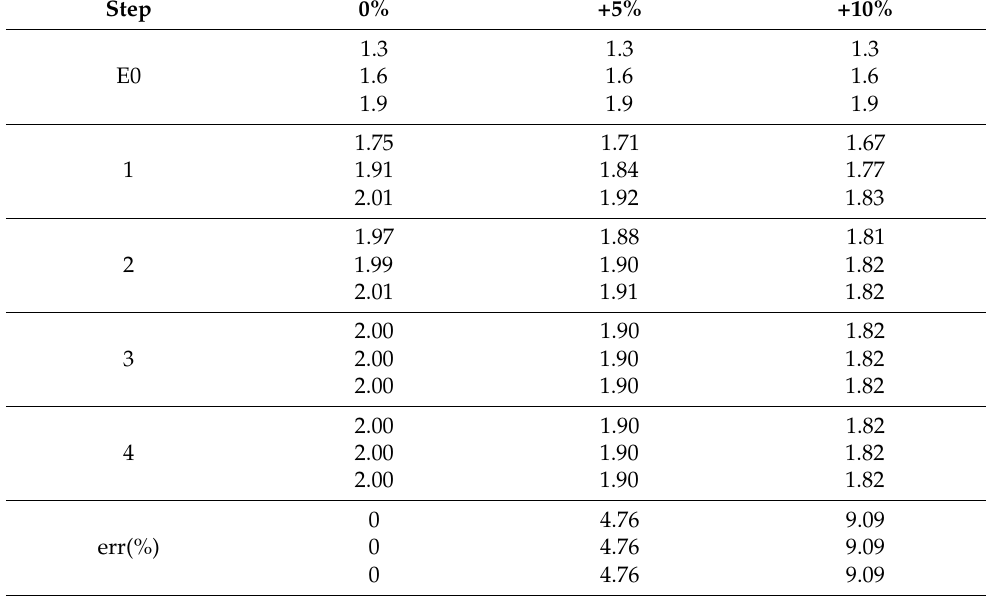
Table 8. Calculation results under different error conditions.